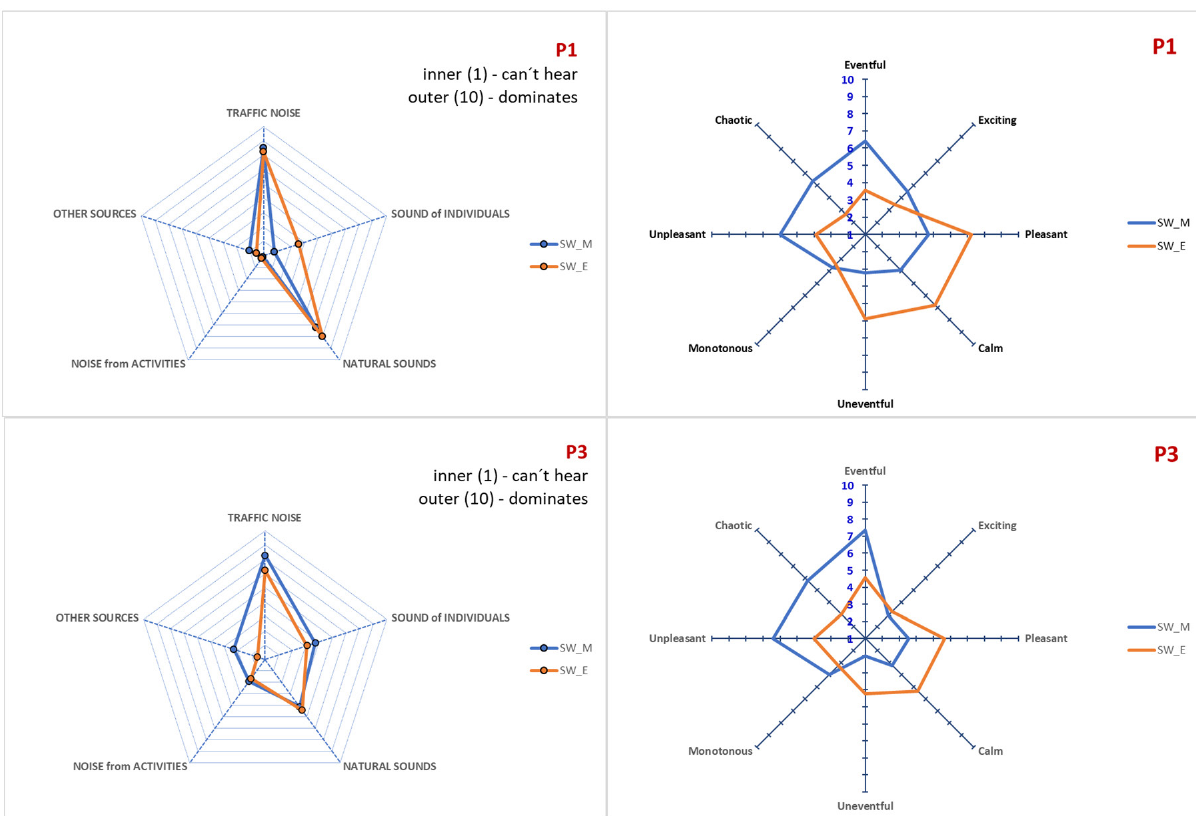
Figure 14: Side by side comparison of assessments at stops number P1 and P3 from questions Q4 (left) and Q5 (right) during morning and evening soundwalks